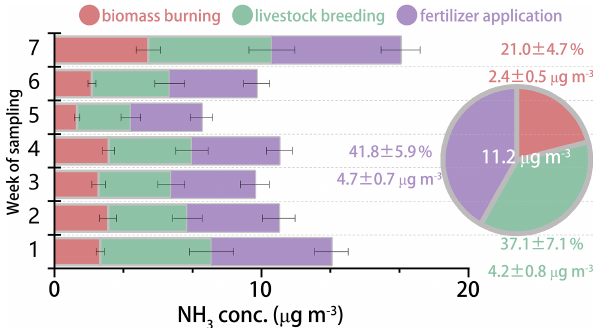
Figure 6. Source apportionment results of ambient NH 3 in rural ar- eas during the dry season based on Bayesian isotopic mixing mod- eling and the isotopic source signatures. The error bars indicate 2 standard